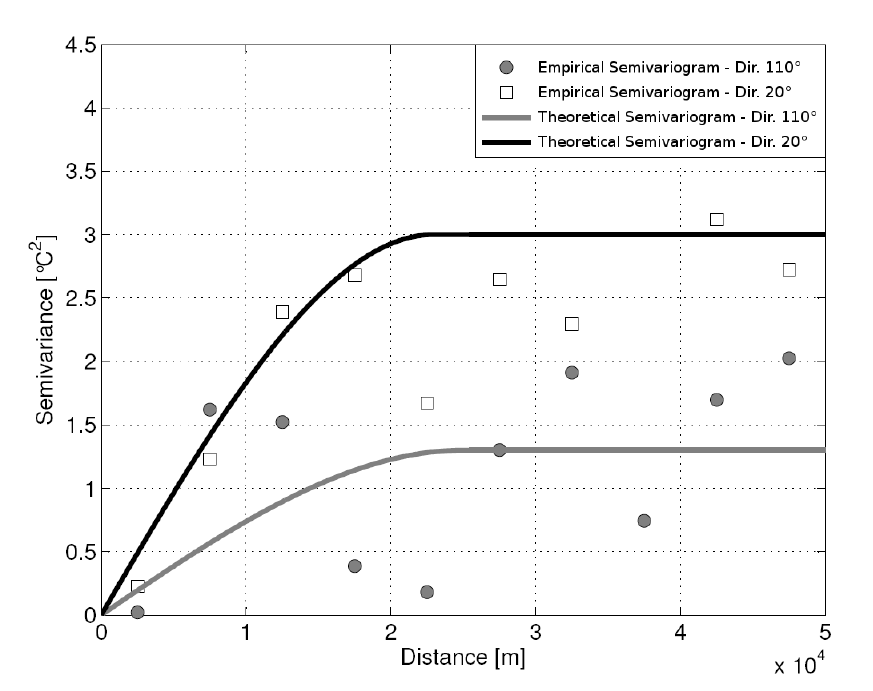
Figure 2. Empirical and theoretical semivariograms of mean annual temperature in the zonal direction (20 ◦ ) and in the principal direction (110 ◦